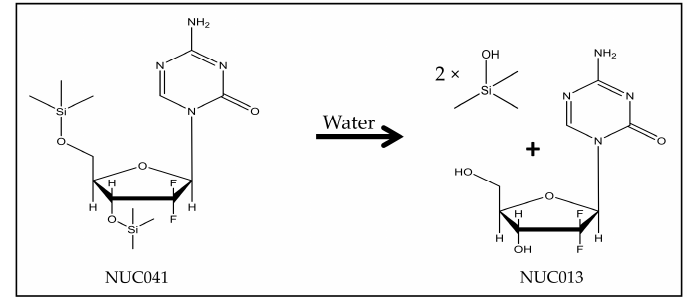
Figure 1. Hydrolysis of NUC041 to NUC013 with release of TMS.